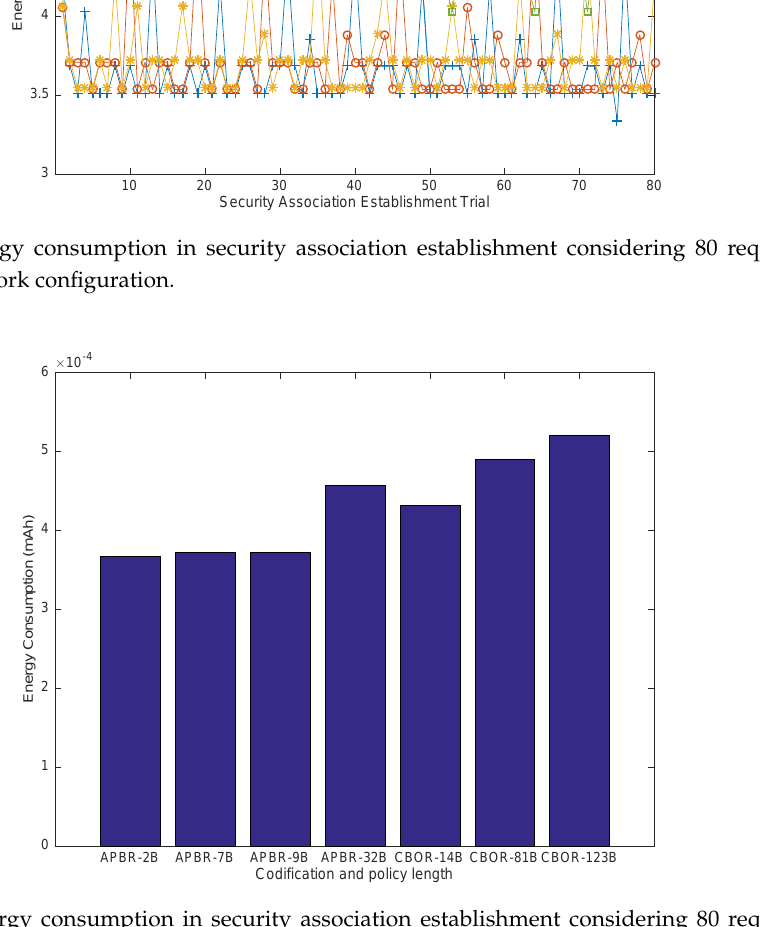
Figure 10. Energy consumption in security association establishment considering 80 requests in a one-hop network